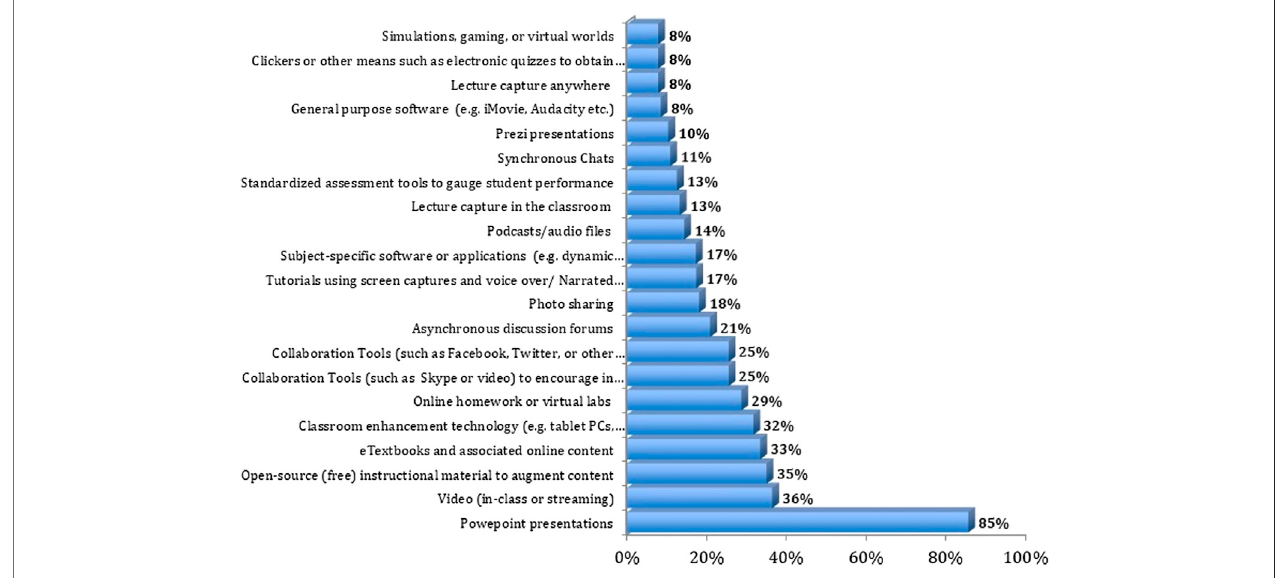
FIGURE 4 | Percentage of instructors always or often using each technological tool in their